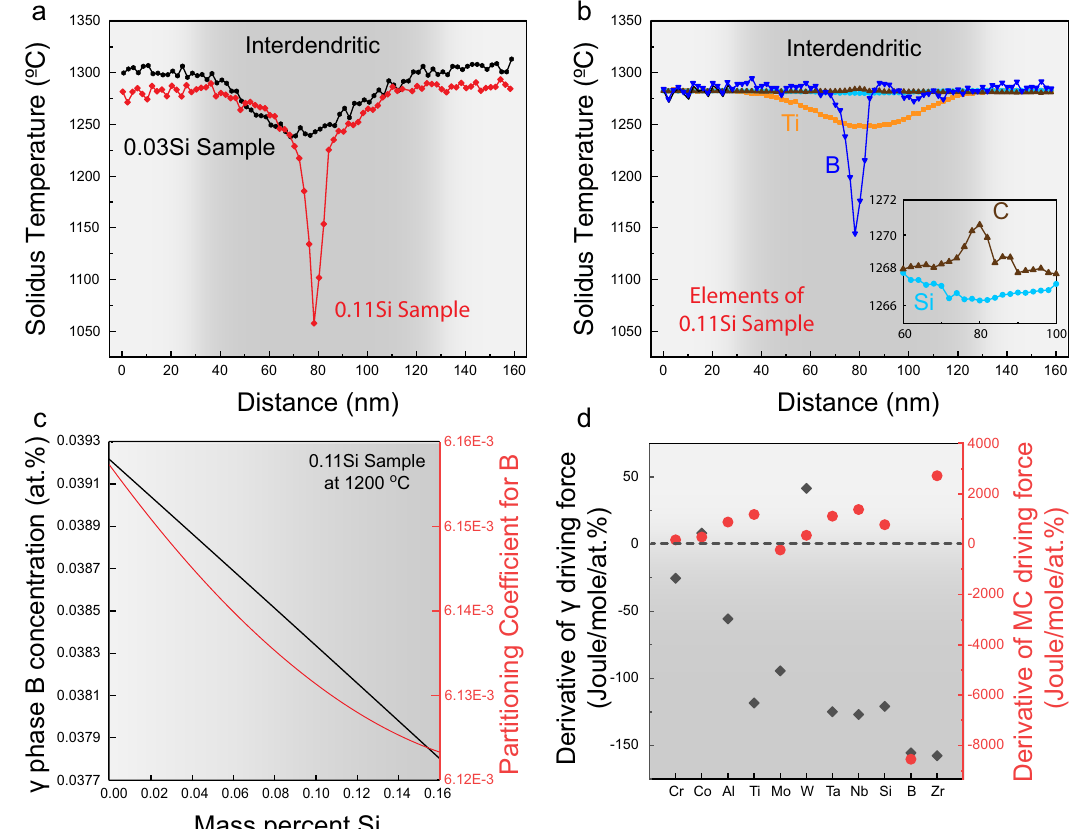
Fig. 6 | Thermodynamic calculations for the solidus temperatures and driving forcesunder variousconditions.a Scheilcalculationbased onactualAPTresults. The solidus temperatures across the dendritic/interdendritic regions for both samples, 0.03Si and 0.11Si are plotted. Each data point was calculated from the respective composition set obtained from the APT experiments in Fig. 4. b The